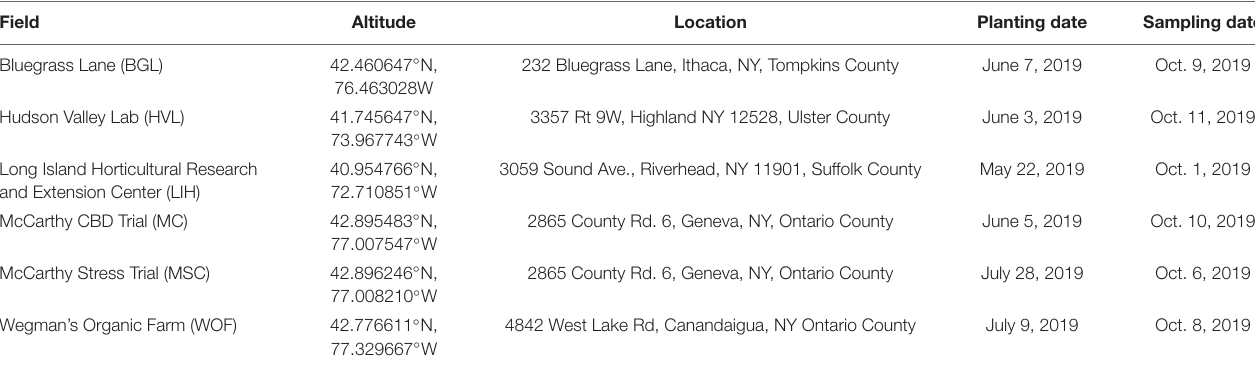
FIGURE 1 | Schematic illustration showing the experimental workflow of a clonal cultivar of hemp grown in six fields distributed at the State of New York (A) . MiSeq sequencing and the DADA2 pipeline were used to determine community composition, and core microbes of roots and rhizosphere soils. Network analysis was performed to provide insight into the core microbial taxa and hub microbes. (B) Hypothetical core microbes of roots and rhizosphere soils selected from bulk soil microbiome. Rhizosphere soil is show by blue line surrounding roots. TABLE 1 | Field locations, planting, and sampling